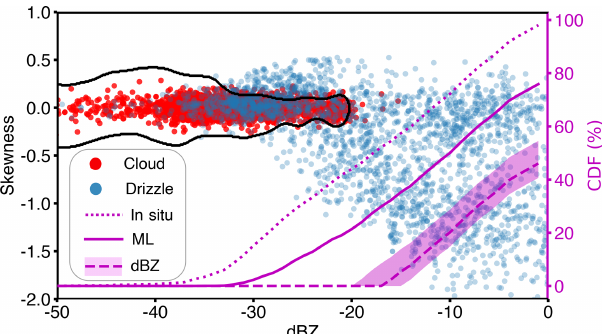
Figure 2. Distribution of the cloud-only (red points) and mixed cloud-drizzle (blue points) samples from in situ observations over the reflectivity–skewness space. The black line indicates the classi- fication boundary of cloud/drizzle resolved by the machine learning algorithm. The right axis indicates the CDF of all correctly identi- fied drizzly samples as a function of reflectivity obtained by each method: the dotted magenta line is for the in situ observations and represents the true value; the solid magenta line is for the ML tech- nique; the magenta shading is for the reflectivity-based technique with an upper boundary of dBZ > − 20 and a lower boundary of dBZ > − 15; the dashed magenta line is for the reflectivity-threshold technique with dBZ > −